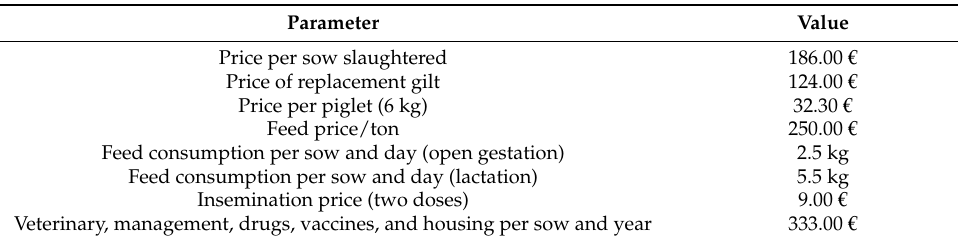
Table 7. Input parameters for calculating the economic outcome in a typical Northeast Spanish sow farm (DARP, 2020).